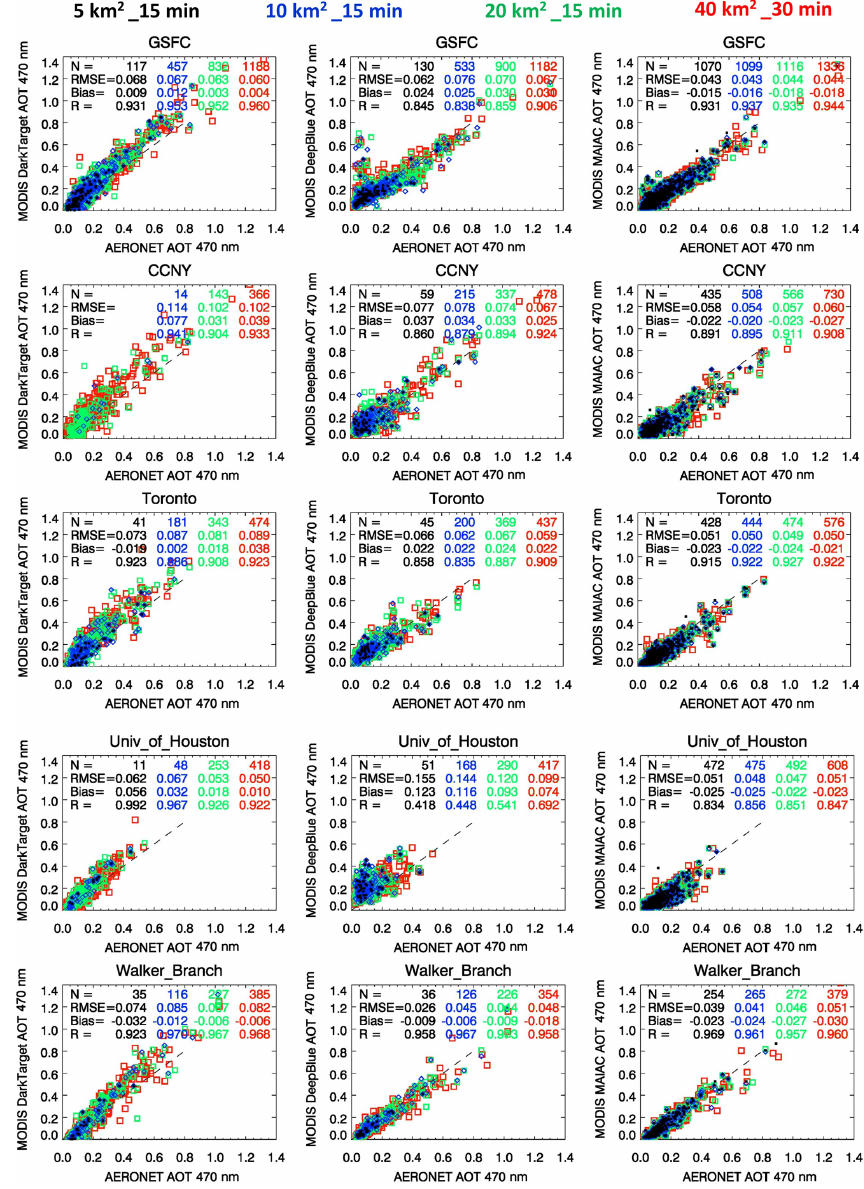
Figure 2. Scatterplots comparing the aerosol optical thickness (470nm) retrieved from the three standard aerosol algorithms of MODIS against that of AERONET for selected sites over eastern, central, and southern parts of North America. Statistical measures of the comparison are depicted within each plot with different color codes denoting matchups obtained following the four spatiotemporal schemes, i.e., black, blue, green, and red for 5, 10, 20, and 40km grid